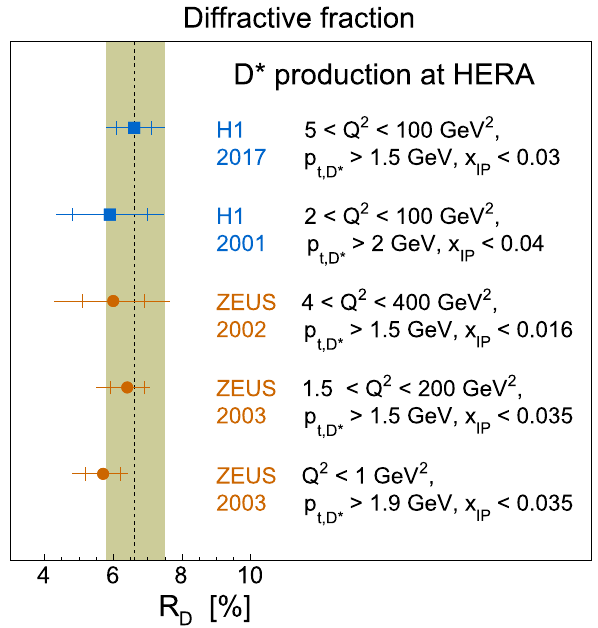
Fig. 8 Integrated diffractive fractions measured in D ∗ production in the deep-inelastic and the photoproduction ( Q 2 < 1 GeV 2 ) regime as measured at HERA previously [20–22,24] and in the present analysis. The inner error bars represent statistical uncertainties, the outer ones the statistical and systematic uncertainties added in quadrature. The dashed line and the shaded band indicate the central value and the total experimental uncertainty of R D of the measurement presented here,